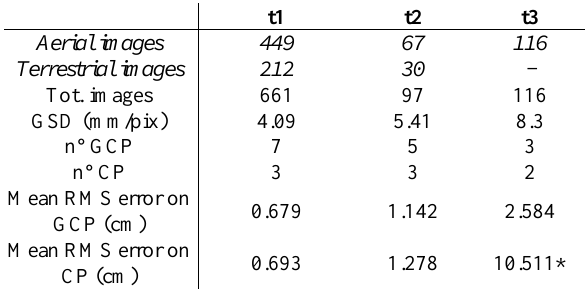
Table 1. Dataset, parameters and results for 3 datasets. The t3 (*) dataset, as expected, was affected by some problems related to both georeferencing and serious structural subsidences.